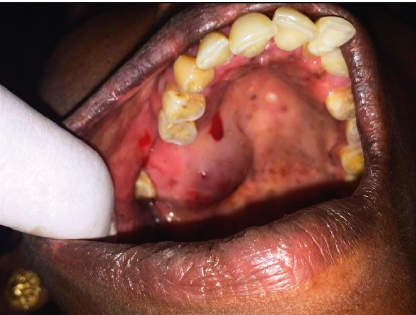
Figure 1: Soft fluctuant swelling in the right posterior part of the palate. Spontaneous bleeding was noted from the lesion.